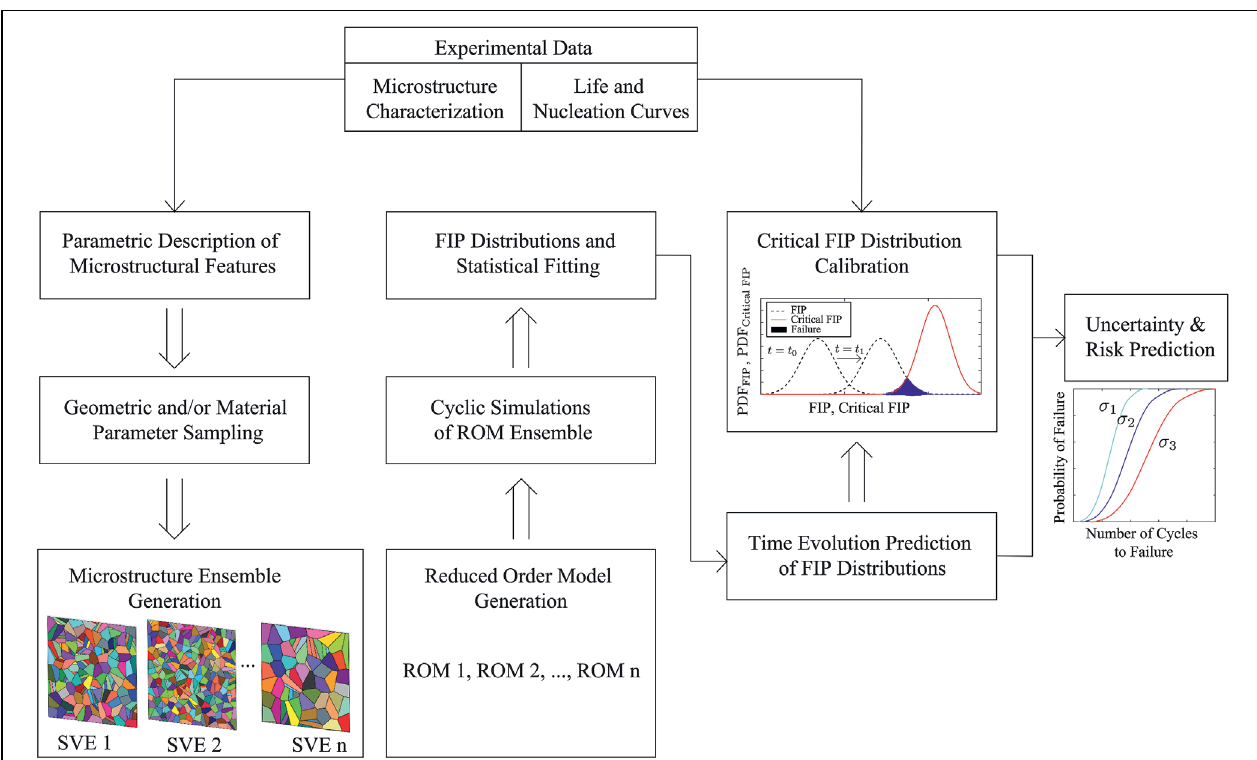
FIGURE 1 | Overview of the proposed uncertainty quantification